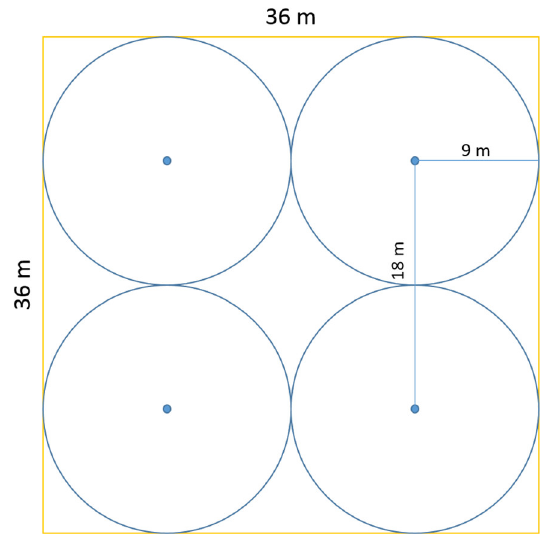
Figure 11. Example of a recommended field plot size and layout for NAIP imagery.